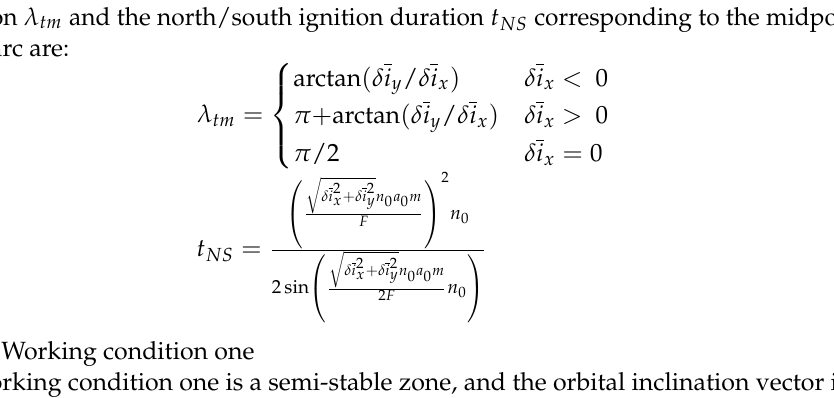
(2) Working condition one Working condition one is a semi-stable zone, and the orbital inclination vector is in a positive bias state. The mean orbital inclination vector has a larger absolute value in the Y-axis direction of the inertial system and a smaller absolute value in the X-axis direction of the inertial system. Therefore, it is necessary to use the maximum orbital control capability to overcome the drift of the orbital inclination vector under the perturbation, and finally make the orbital inclination vector approach the target orbital inclination. In this condition, the ignition duration of the control is longest, and the ignition position fluctuates a small amount with the current orbital inclination vector within the range of the SK zone. The NSSK in working condition one is shown in Figure